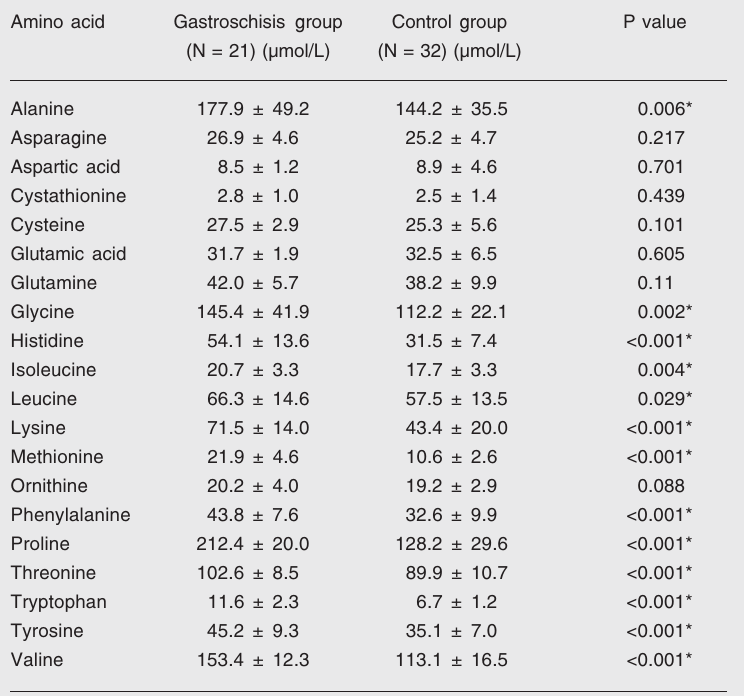
Table 2. Concentrations of twenty amino acids in amniotic fluid samples of fetuses with gastroschisis and